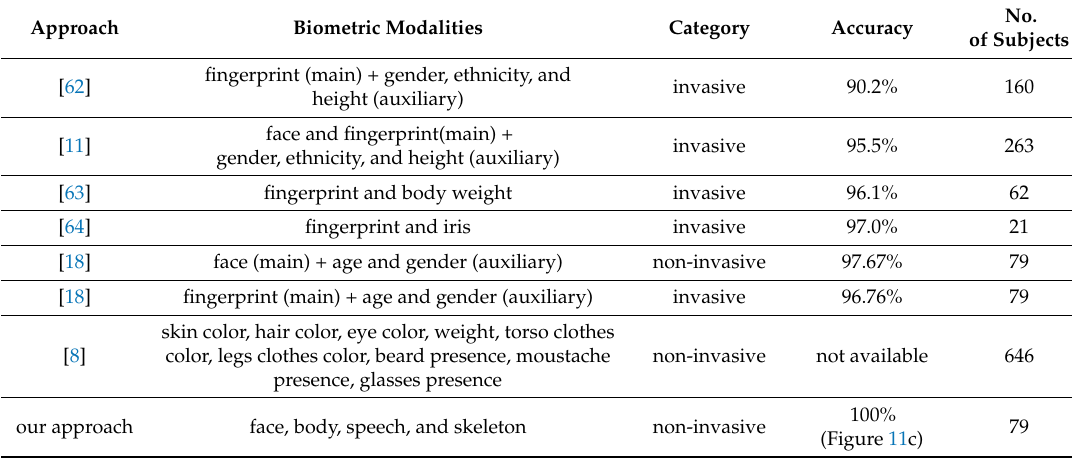
Table 1. Comparison with related